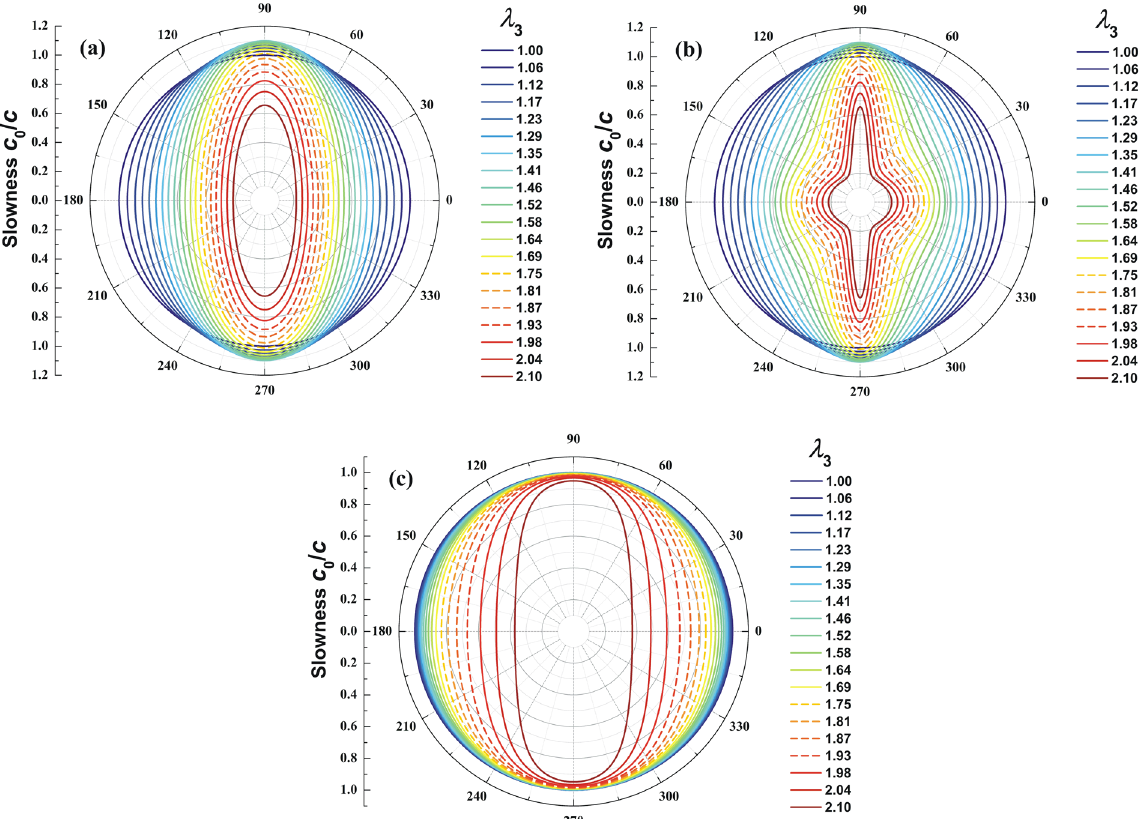
Figure 3. Slowness surface polar diagrams for self-controlled elastic waves in a compressible hyperelastic medium in yz plane: ( a ) purely-transversal velocity; ( b ) quasi-transversal velocity; ( c ) quasi-longitudinal velocity. Solid and dashed lines denote stable and unstable regimes,